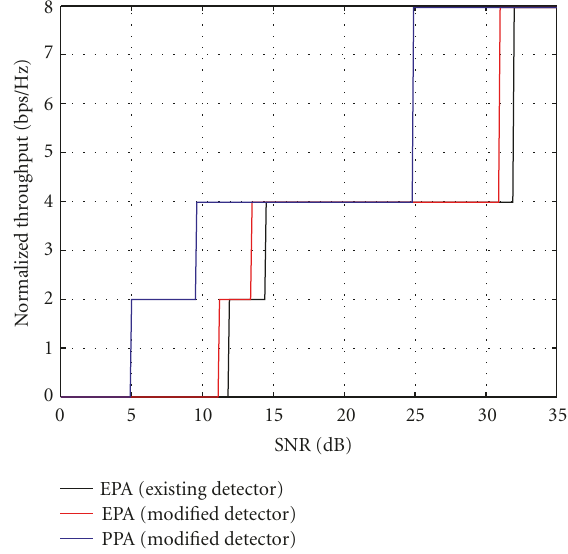
Figure 6: BER performance of di ff erent power allocation schemes (QPSK, M R = 4, M T = 2).